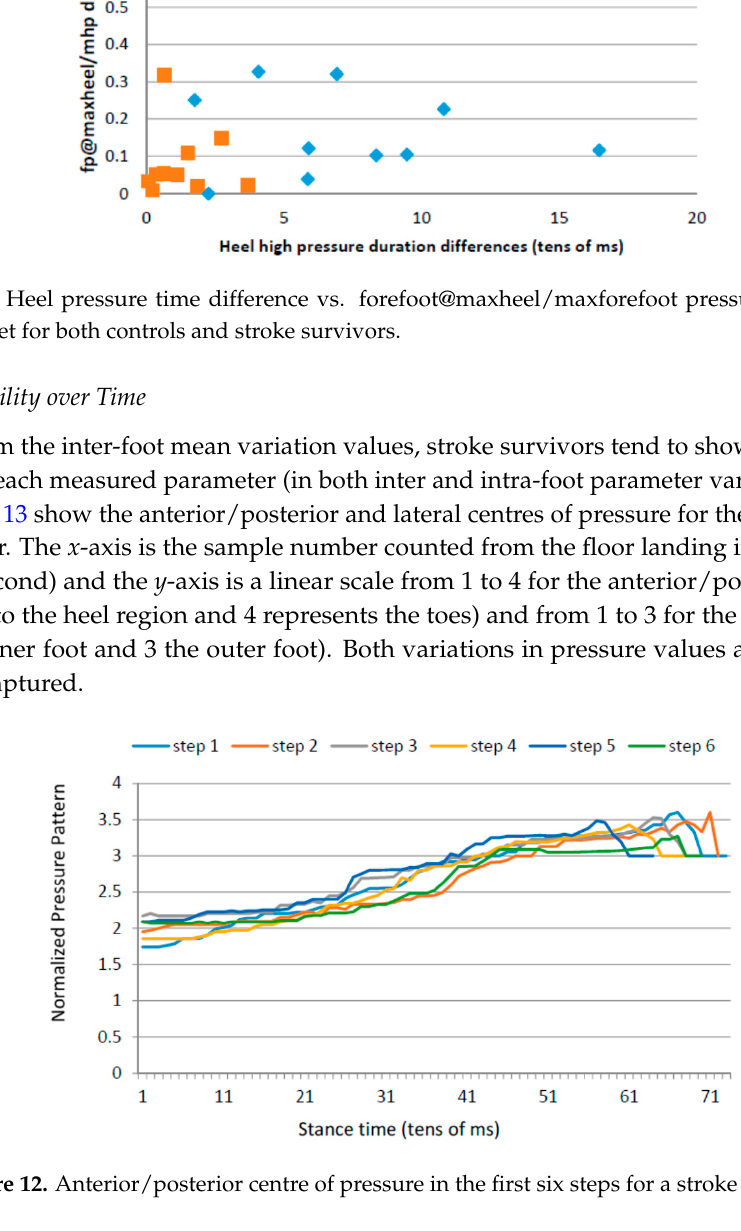
Figure 11. Heel pressure time difference vs. forefoot@maxheel/maxforefoot pressure differences between feet for both controls and stroke